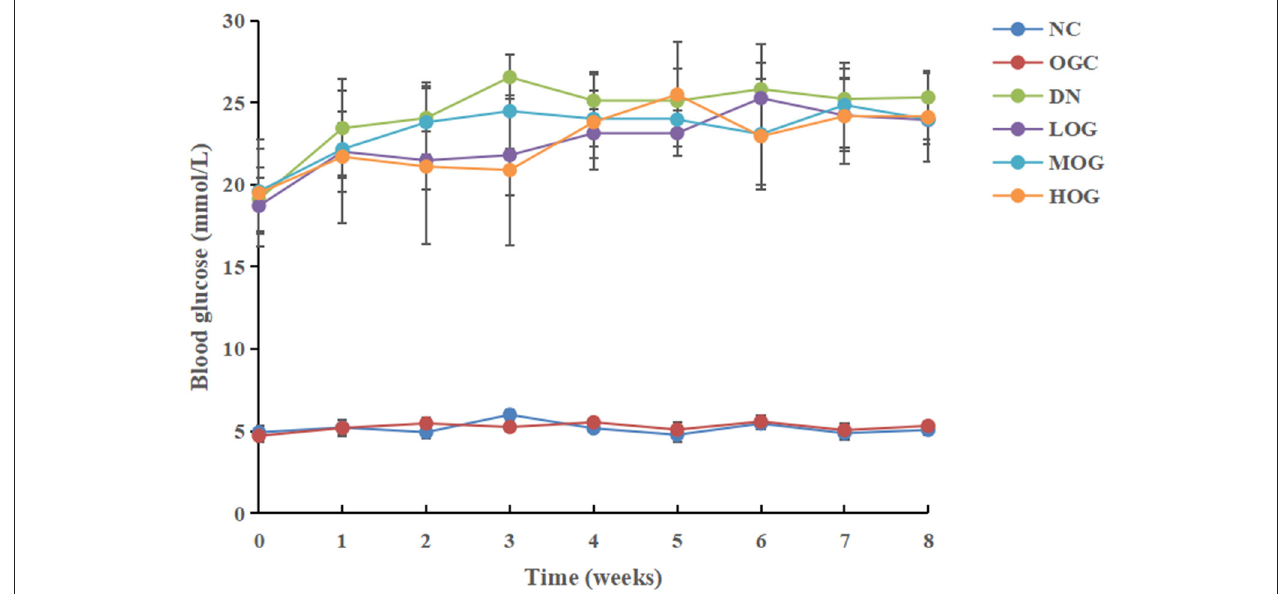
FIGURE 1 | Blood glucose level changes of the rats in each group over